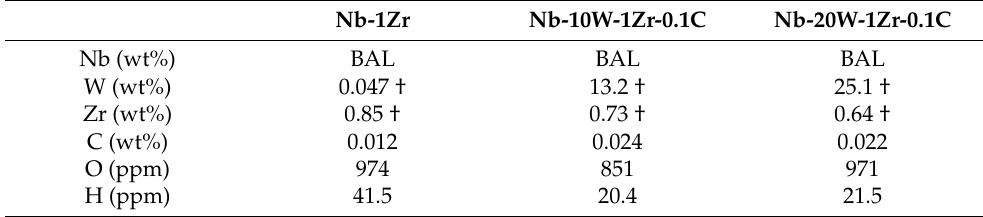
Figure 9. Build photos and IR images depicting ( A ) limited melt pool ejection in Nb-1Zr and ( B ) W cluster melt pool ejection typical of the Nb-W powders. IR images are not emissivity corrected and were taken from above during EB-PBF. Table 3. Chemical analysis of solid EB-PBF fabricated